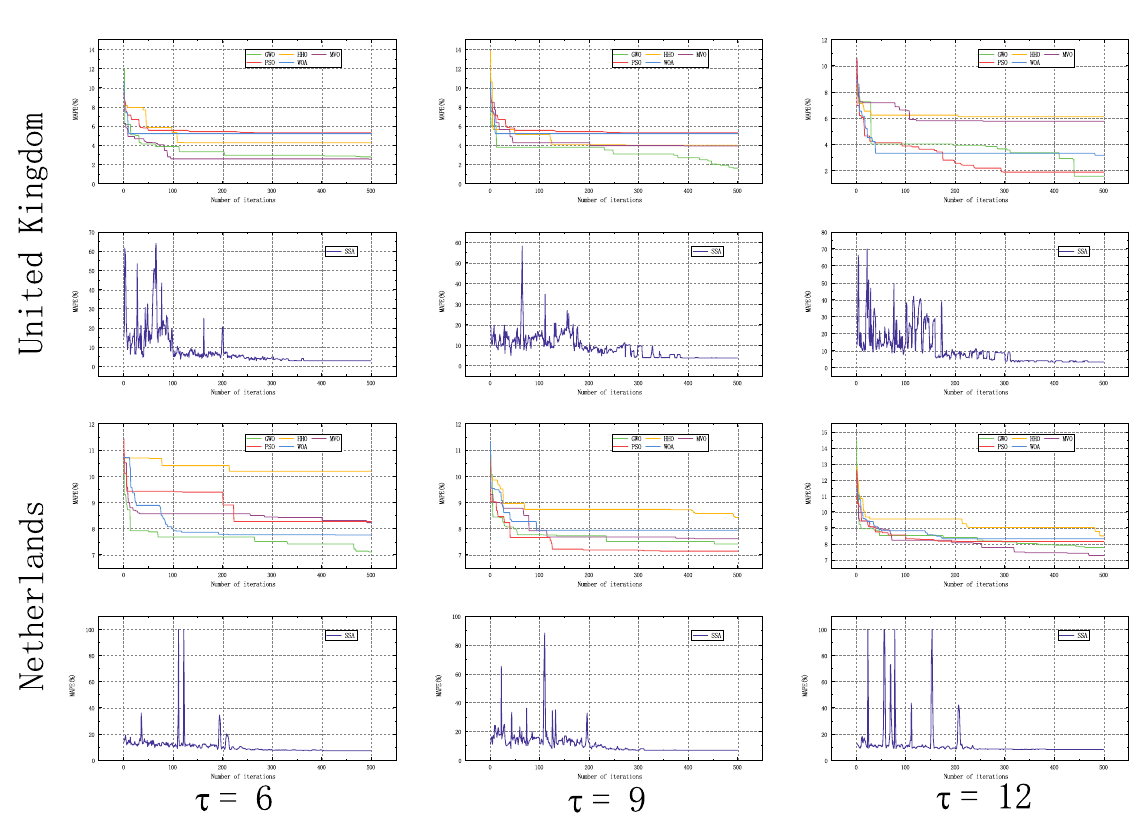
Figure 7. Convergence curves by GWO, HHO, MVO, PSO, WOA and SSA for XGBoost in different